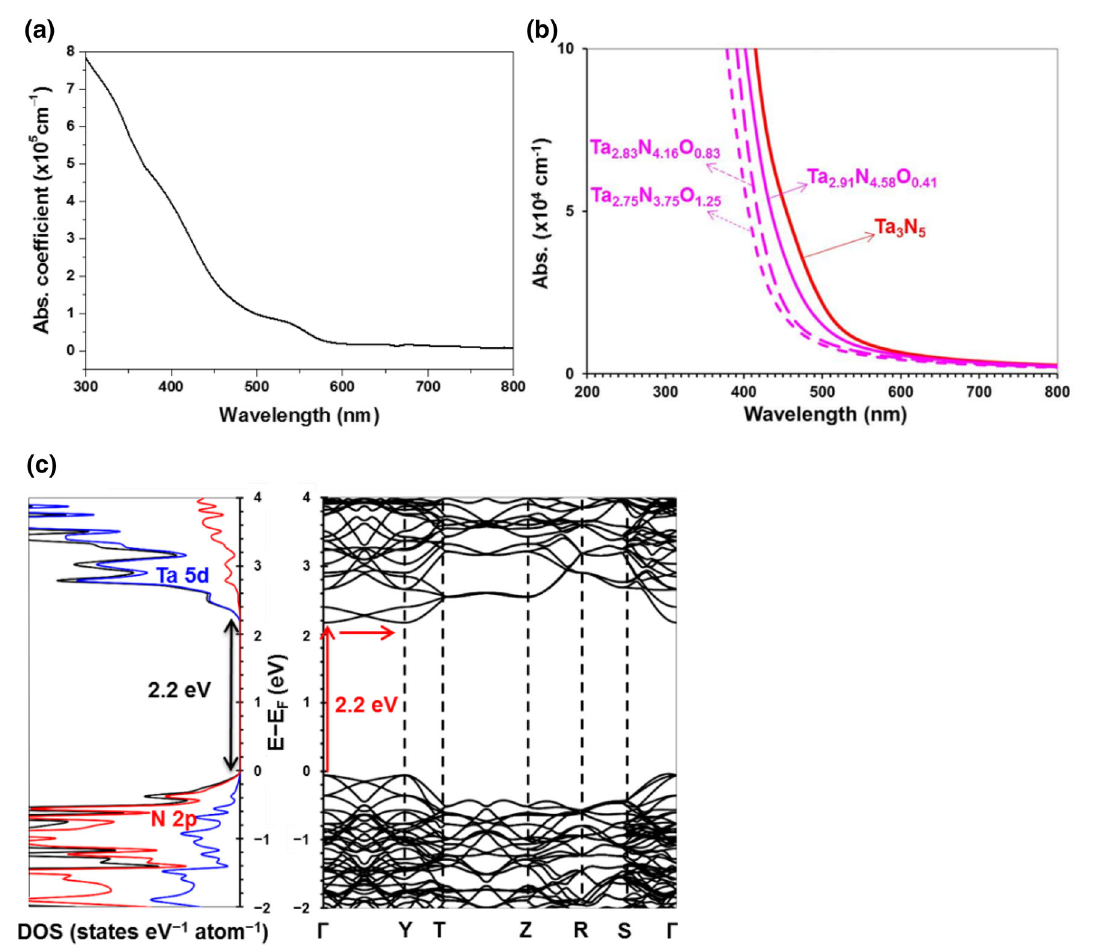
Fig. 5 Absorption coefficient a obtained from experimental mea- surement, adapted from [41] with permission from the PCCP Owner Societies and b obtained from theoretical calculation, adapted from [44] with permission from the PCCP Owner Societies, and c electronic density of states (DOS) and k -space band structure diagrams